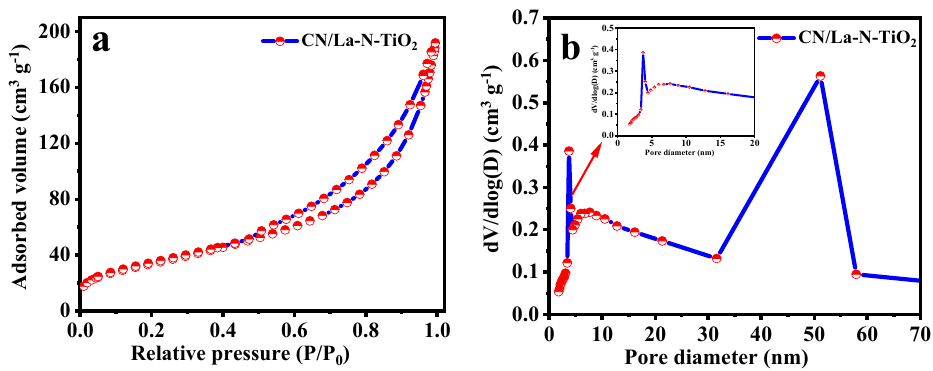
Figure 5. ( a ) N 2 adsorption − –desorption isotherms and ( b ) the corresponding pore size distribution plots of CN/La-N-TiO 2 .